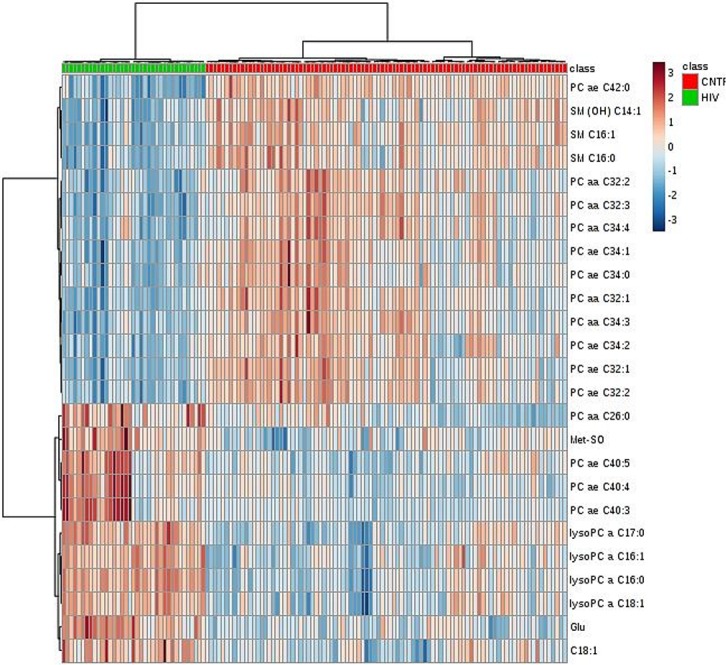
Unsupervised Heat map Clustering Analysis depicting identification of metabolites able to differentiate between Cases and Controls.